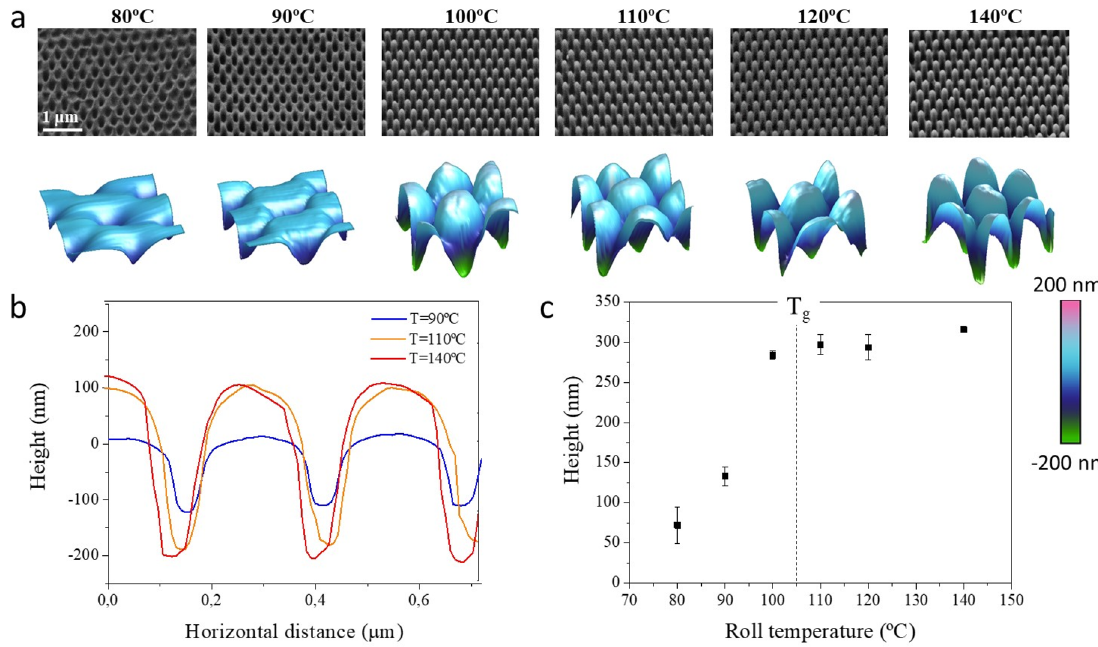
Figure 2. ( a ) SEM images of PMMA R2R nanoimprinted moth-eye structures fabricated at web speed of 0.02 m·min −1 at temperatures as noted. The images were acquired at a tilting angle of 45° and at an equivalent rotation angle in all cases. The bottom row shows 3D reconstructions of AFM surface scanned images of 550 × 550 nm 2 imprinted areas. ( b ) AFM height profiles corresponding to different processing temperatures. ( c ) Height dependence of the moth-eye nanocone structures with the processing temperature. The dotted line marks the glass transition temperature of the bulk